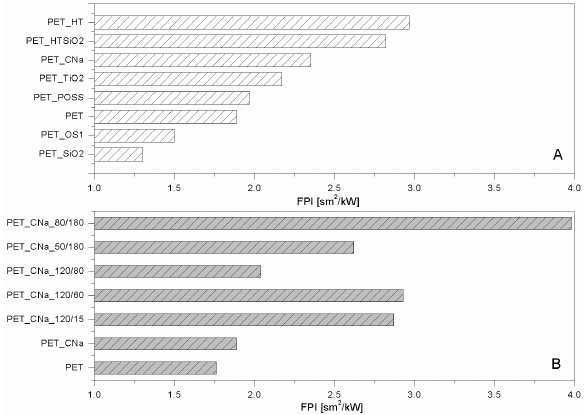
Figure 3. FPI values of NP-treated PET fabrics ( A ) and treated initially by plasma and then with CNa suspension ( B ) [33,35]. Data obtained by cone calorimetry at 35 kW/m 2 .